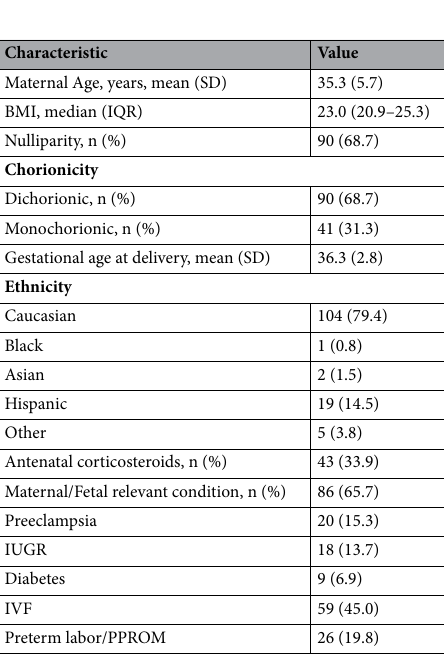
Figure 1. Flowchart of the eligible cases.